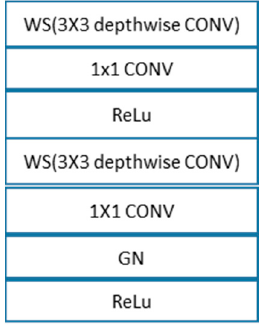
Figure 5. Components of one SD-UNet Block.